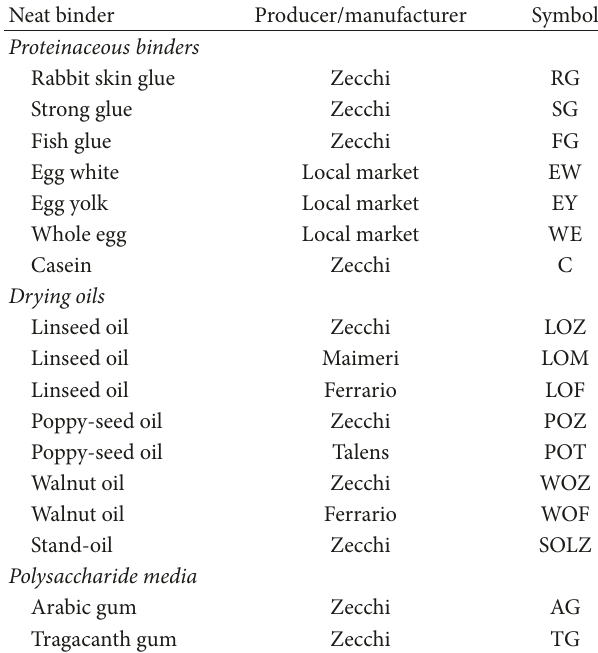
Table 1: The neat binding media analyzed with reporting the manu- facturer and the corresponding identification